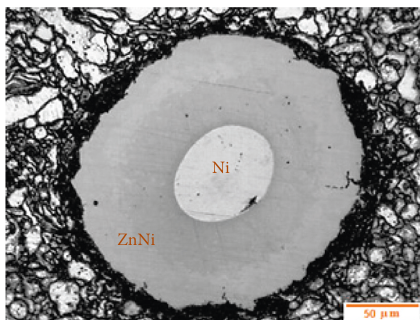
Figure 7: Optical microstructure of the Zn-Ni alloy obtained at 50x, showing Zn-Ni intermetallic